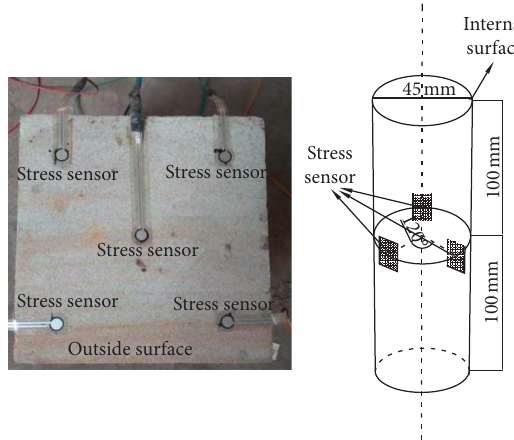
Figure 5: Physical picture of the surrounding rock.